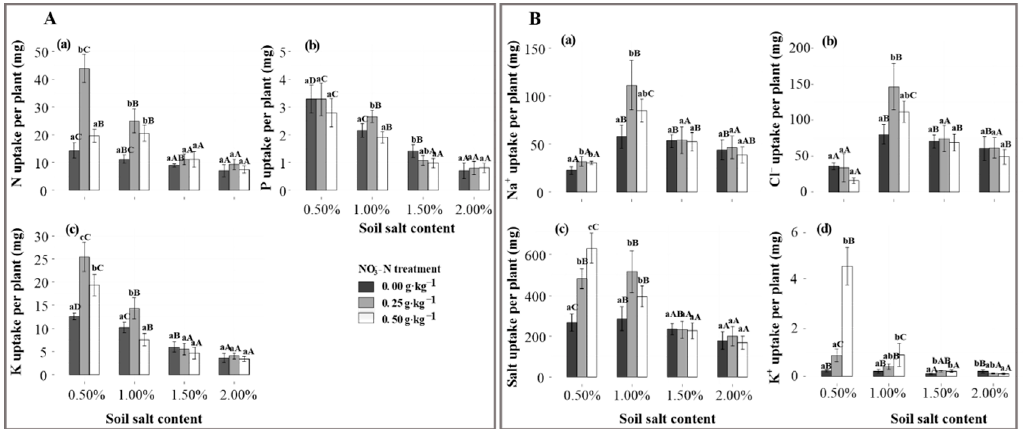
Figure 3. Effects of salt and NO 3 − -N on nutrient ( A ) and ion ( B ) uptake by the shoots of Suaeda salsa . ( A ( a – c )) represent the absorptions in nitrogen (N), phosphorus (P), and potassium (K), and ( B ( a – d )) represent the absorptions in Na + , Cl − , salt, and K + . Capital letters indicate significant differences among the four salt levels. Lowercase letters indicate significant differences among the three—N